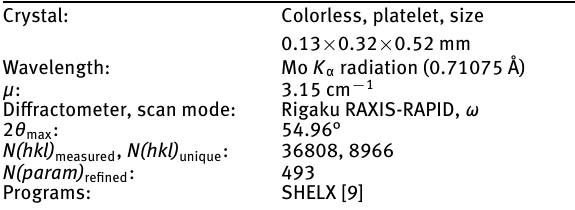
Table 1: Data collection and handling.